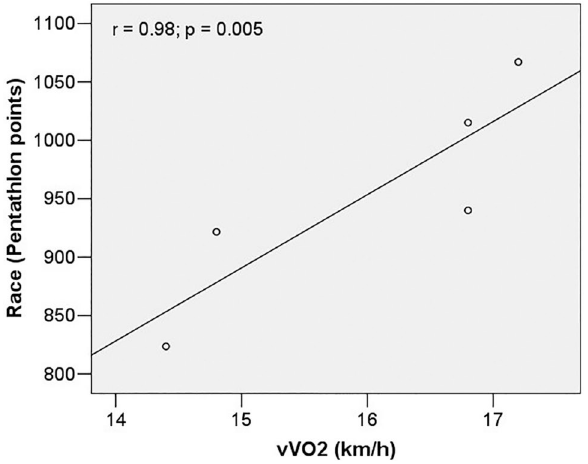
Figure 2 - Dispersion graph of maximum velocity and race performance points (n=5). The coefficient correlation (r) = 0.95 is classified as very strong, showing a significant relationship between 4 km cross country race performance and maximum velocity reached in the cardiopulmonary